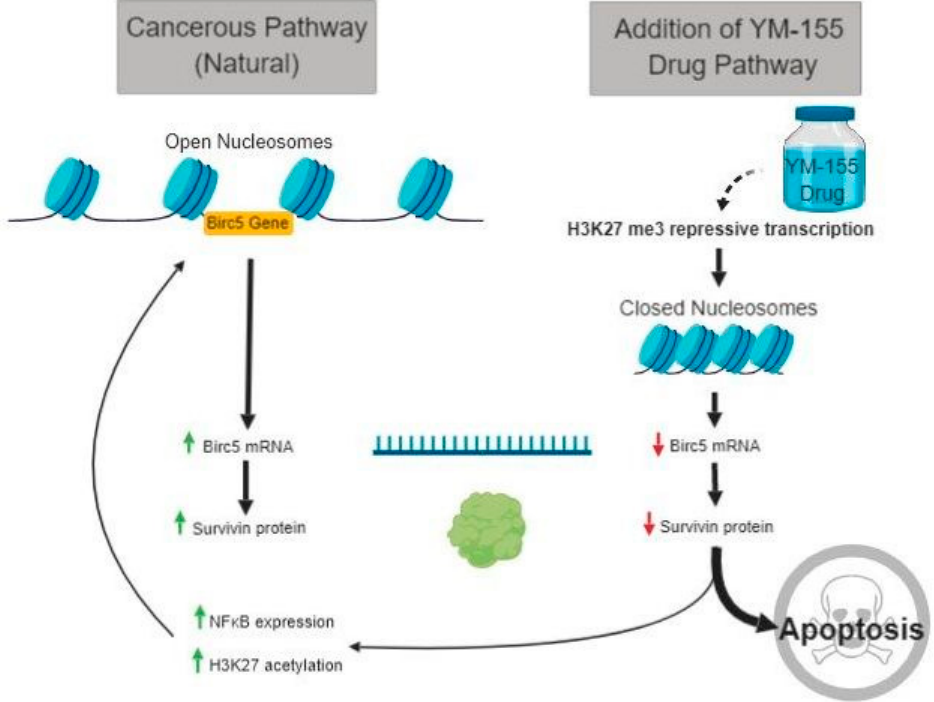
Figure 9. Survivin protein expression pathway in both control synovial sarcoma cells and YM155 treated synovial sarcoma cells.